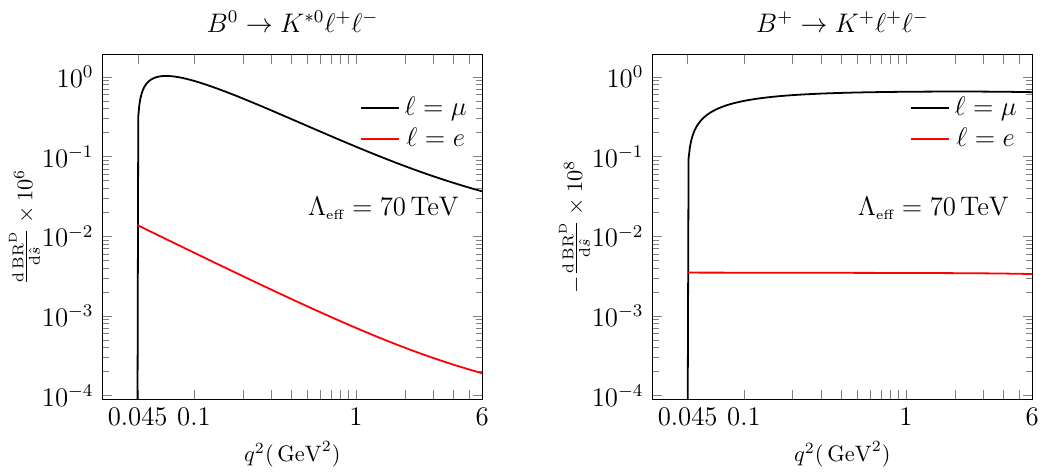
Figure 9 . The contribution of the magnetic-dipole interaction to the d BR DP =d ^ s as a function of q 2 for a representative value of (cid:3) e(cid:11) =